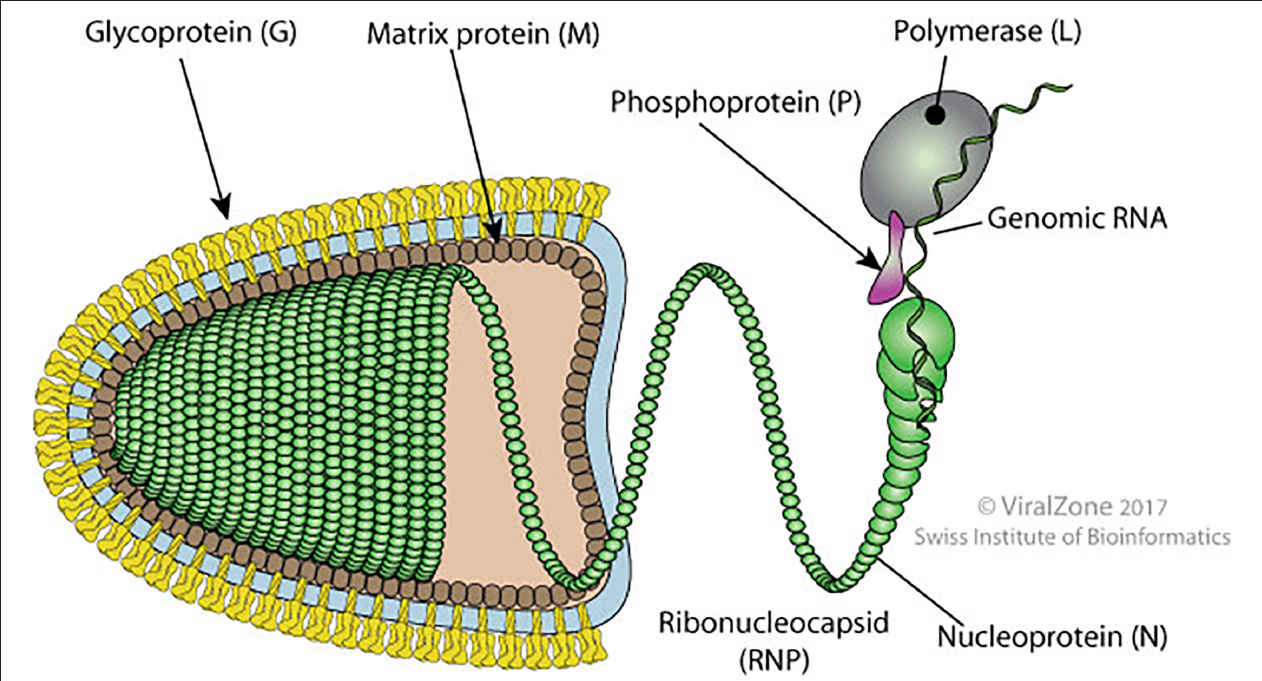
FIGURE 2 | Schematic diagram of bullet shape structure of RABV showing different proteins (original source of the image; Philippe Le Mercier, SIB Swiss Institute of